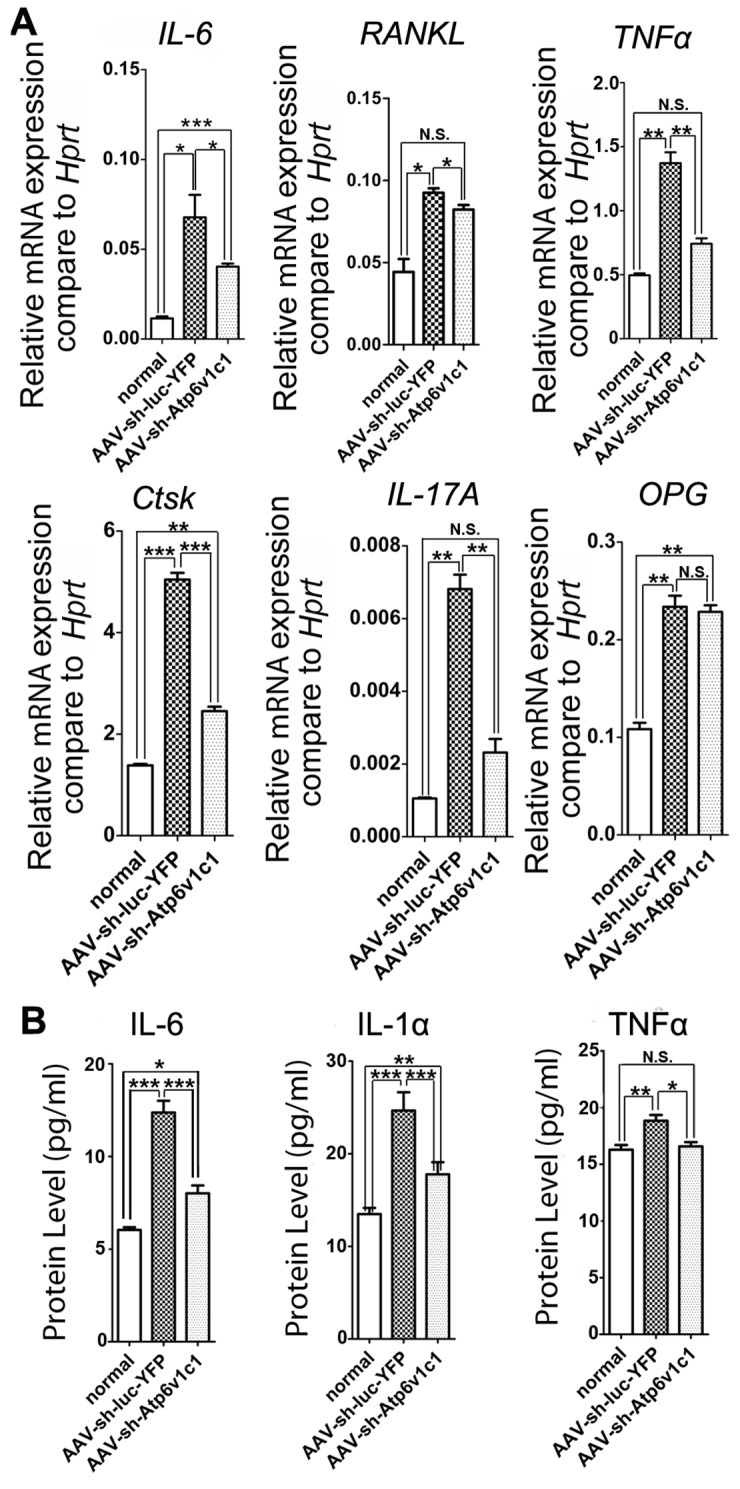
The expression of osteoclast marker genes and cytokines in the periodontal tissues were reduced by AAV-sh-Atp6v1c1.(A) osteoclast-specific genes (i.e. Ctsk), osteoclast differentiation genes (i.e. RANKL and OPG), and cytokines (i.e. IL-6, IL-17A and TNFα) in different groups. Expression levels were normalized to the housekeeping gene hypoxanthine-guanine phosphoribosyl transferase (Hprt). (B) IL-6, IL-1α and TNFα levels in the periodontitis lesion area were detected by ELISA. *: P < 0.05, **: P < 0.01, ***: P<0.001, N.S: P > 0.05.